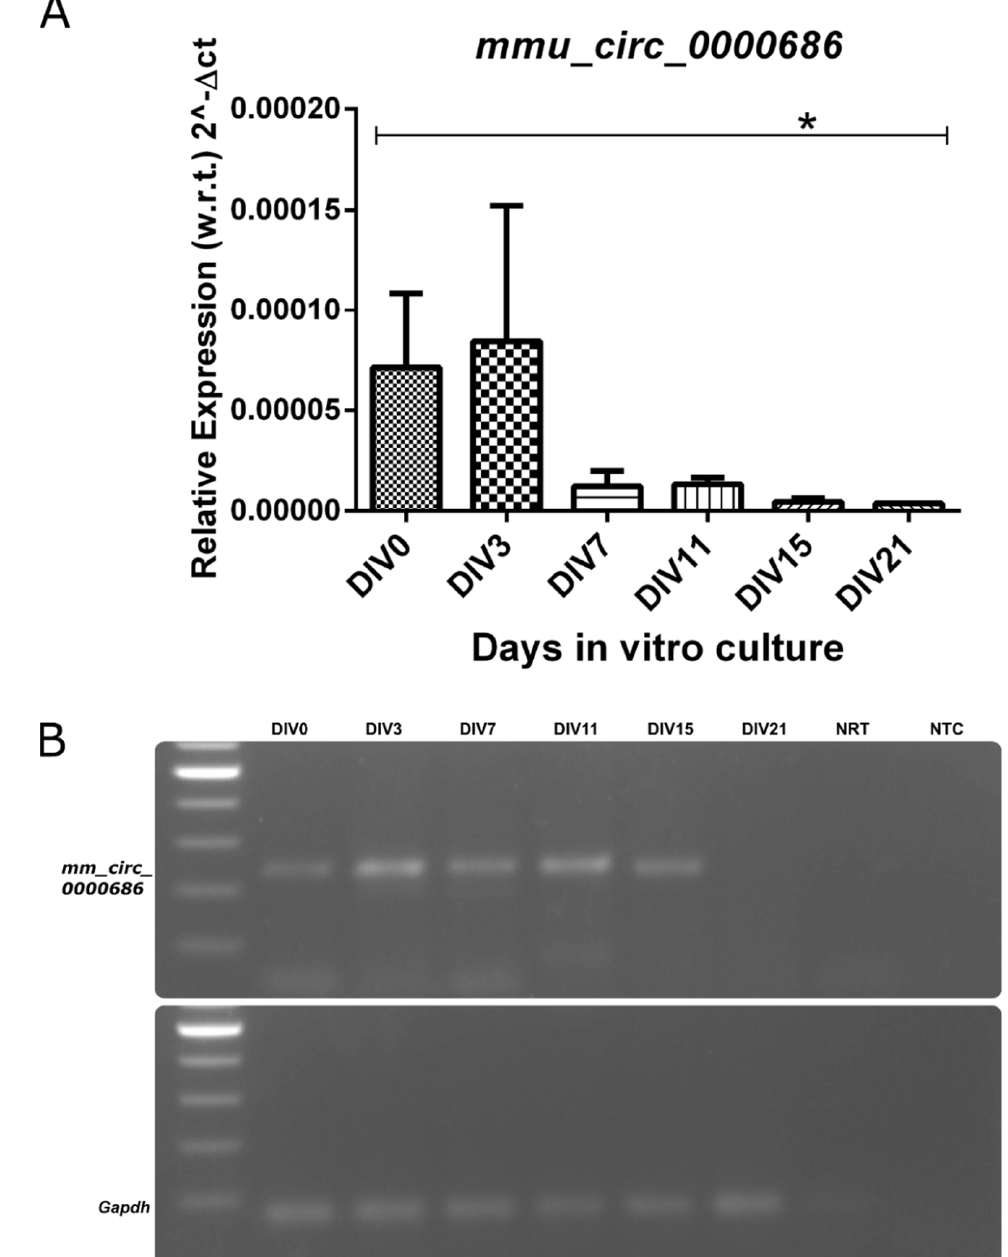
Figure 5. The expression of circular RNA decreases, as cortical neurons mature. ( A , B ) Circular RNA expression was measured at DIV0, DIV3, DIV7, DIV11, DIV15, and DIV21 with respect to Gapdh by quantitative RT-PCR. DIV (days of in vitro culture). (Data are shown as mean ± SD; N = 3 biological replicates; n = 3 technical replicates; t -test, * p < 0.05).